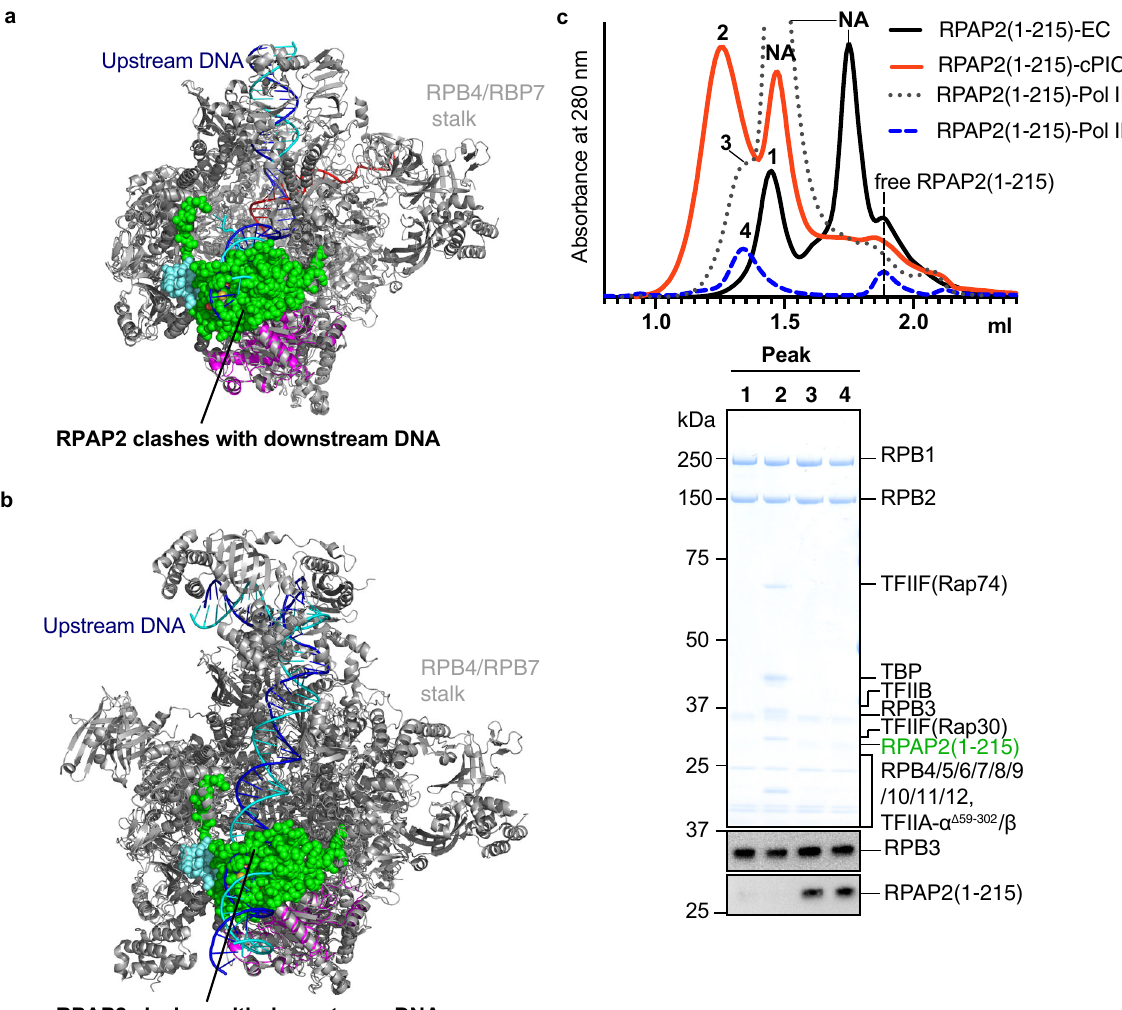
Fig. 2 RPAP2 binding is incompatible with transcription initiation and elongation. a Superposition of the Pol II-RPAP2 structure onto the Pol II elongation complex (PDB: 5FLM) reveals that RPAP2 would clash with downstream DNA (blue/cyan). b Superposition of the Pol II-RPAP2 structure onto the Pol II pre-initiation complex (PDB: 5IYA) reveals that RPAP2 would clash with downstream DNA (blue/cyan). c Binding competition assays using the preformed Pol II – RPAP2(1 – 215) complex (peak 4) show that RPAP2 is displaced from Pol II upon formation of an elongation complex (peak 1) or a pre-initiation complex (peak 2) but cannot be displaced by double-stranded promoter DNA (peak 3). Chromatograms show the formation of complexes and the relevant peak fractions used for SDS – PAGE and western blot analysis are indicated. Peaks for free nucleic acids are indicated by NA and vertical dashed lines show the elution peak of free RPAP2(1 – 215). A representative western blot analysis of the same peak fractions using anti RPAP2 (Thermo Fisher #PA5-61244) and anti RPB3 (BETHYL #A303-771A) antibodies are shown. Please refer to Supplementary Fig. 5 for source data of western